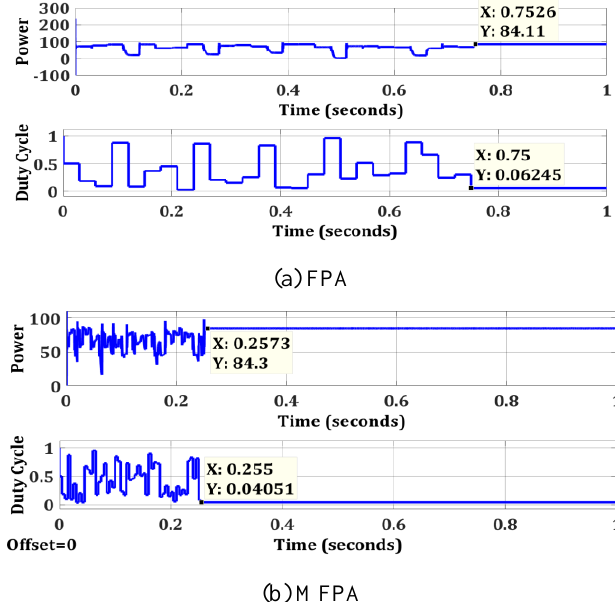
Fig. 12. Performance comparison of (a) FPA and (b) MFPA under Strong PSC